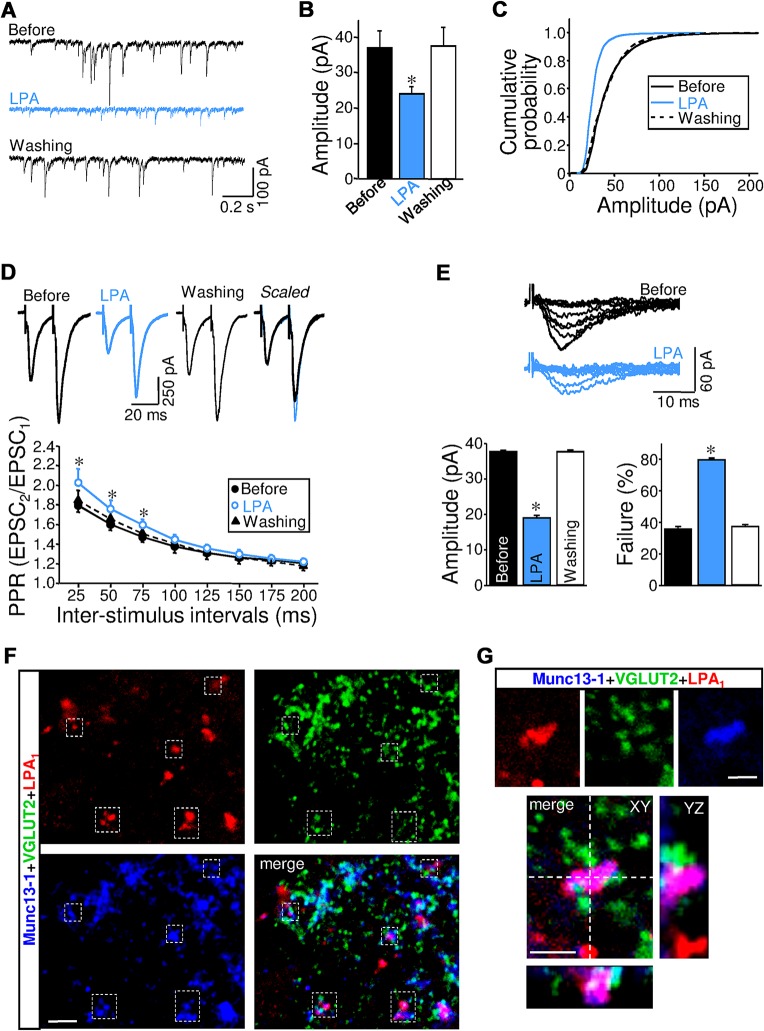
Presynaptic LPA signaling induces excitatory STD.(A) Current traces of sEPSCsAMPA recorded from a HMN at the indicated conditions. The recording of sEPSCsAMPA was performed under conditions of facilitated synaptic release without TTX in a modified extracellular solution containing high-Ca2+ (4 mM), high-K+ (9 mM), and the receptor antagonists indicated in Fig 2B. (B) Mean sEPSCsAMPA amplitude for LPA-treated group (2.5 μM) compared to their respective pretreatment (before) and washout periods (n = 4 HMNs). (C) Normalized cumulative probability distributions of sEPSCsAMPA amplitude for each condition. Bin width: 2 pA. Note that the cumulative distribution of sEPSCsAMPA amplitude shifted to the left (p < 0.001; Kolmogorov-Smirnov test). (D) Top, eEPSCsAMPA recorded in a HMN at the indicated conditions in response to paired-pulse stimulation of VLRF. The rightmost trace shows the superimposition of the responses scaled to the peak of the first eEPSCsAMPA. Bottom, comparison of PPR measured at specified interpulse intervals for HMNs recorded at the indicated conditions (n = 4 HMNs). Paired-pulse ratio (PPR) was obtained from the amplitude of the first and second eEPSCsAMPA by the formula eEPSCsAMPA2/eEPSCsAMPA1. The stimulus intensity was adjusted so that the eEPSCAMPA1 was approximately 50% of maximal amplitude, then maintained constant throughout the recording period. (E) Top, superimposition of 10 successive eEPSCsAMPA evoked at 0.2 Hz by minimal stimulation of VLRF in HMN before and after treatment with LPA. Characteristically, the intensity of the stimulation was set to elicit eEPSCsAMPA with 30% to 40% failure at the control (before) condition. Bottom, mean eEPSCsAMPA amplitude (left) and failure rate (right) at indicated conditions (n = 4 HMNs). Experiments and analysis described in A–E have been performed as in our previously published study [8]. *p < 0.05, one-way (B, E) or two-way (D) RM-ANOVA relative to control (before) condition. (F) Confocal images of the HN obtained from P7 rats processed by triple immunolabeling for LPA1, VGLUT2 and the presynaptic active zone (a.z.) marker Munc13-1. Note triple colocalizations within the boxed areas. (G) 3-D reconstruction showing LPA1 expression in the presynaptic a.z. of a glutamatergic bouton. Note that LPA-ir colocalizes with Munc13-1 and with a VGLUT2-ir SVs pool in the three planes. The xz- and yz-planes are located as indicated by the white dashed lines. Scale bars: F, 5 μm; G, 2 μm. Plots data can be found in S1 Data.